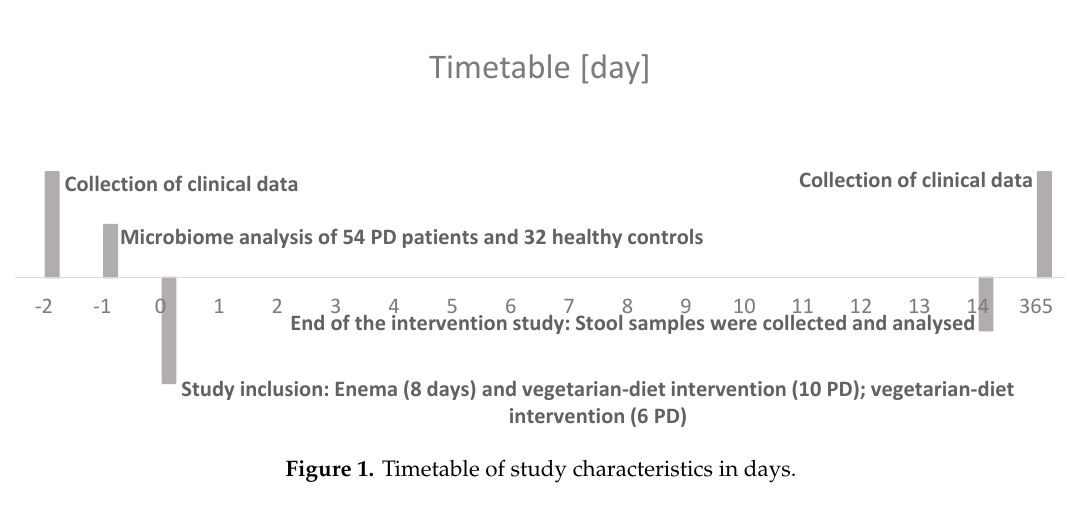
Table 3. Ingredients during the two-week diet which all patients with Parkinson’s disease (PD) have